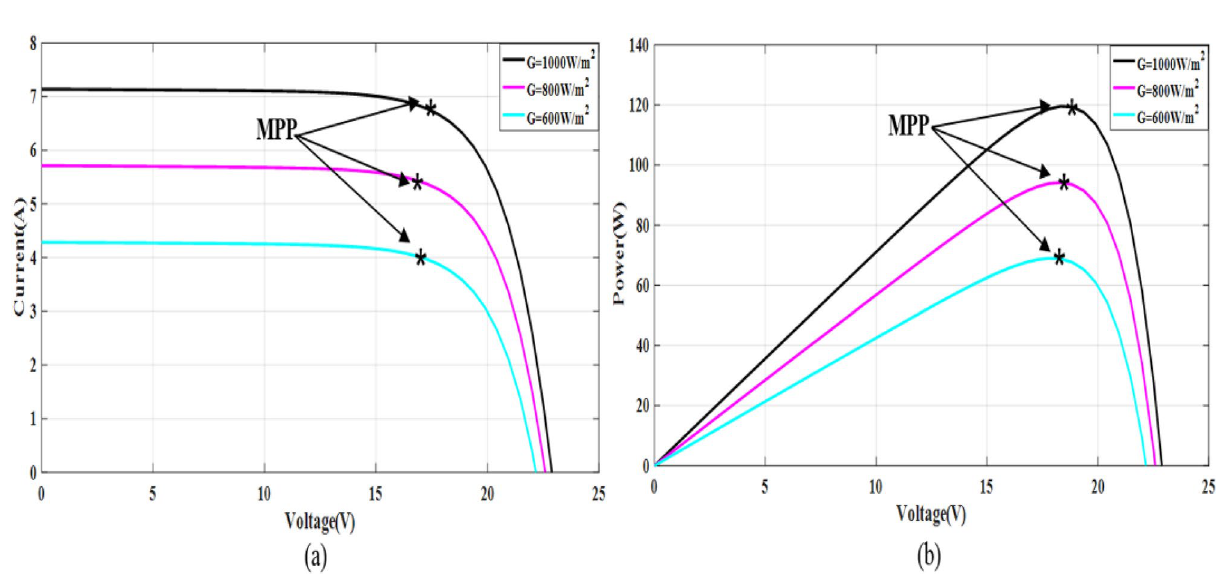
Figure 13. I – V and P – V graphs of double-diode model under different values of irradiation and constant temperature, T = 25 °C ( a ) I – V graph and ( b ) P – V